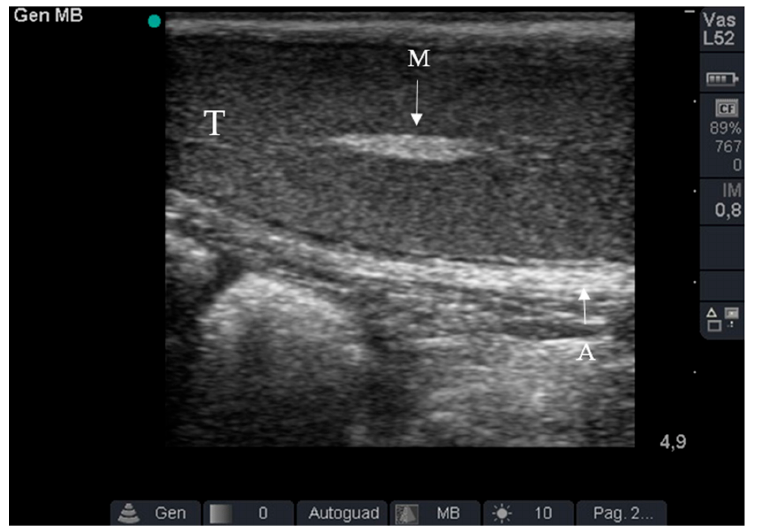
Figure 1. Ultrasound of the undescended testicle. Note peripheral hyperechogenicity of the tunica albuginea (A), the homogeneous parenchymatous echo-texture typical of the testis (T), and the hy- perechogenicity of mediastinum